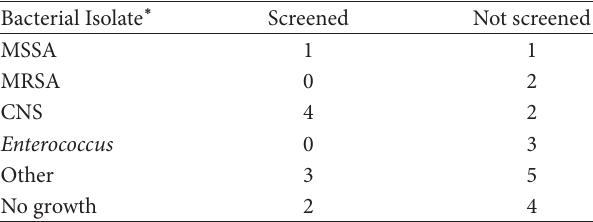
Table 3: Frequencies of organisms isolated from culture specimens, grouped by screening